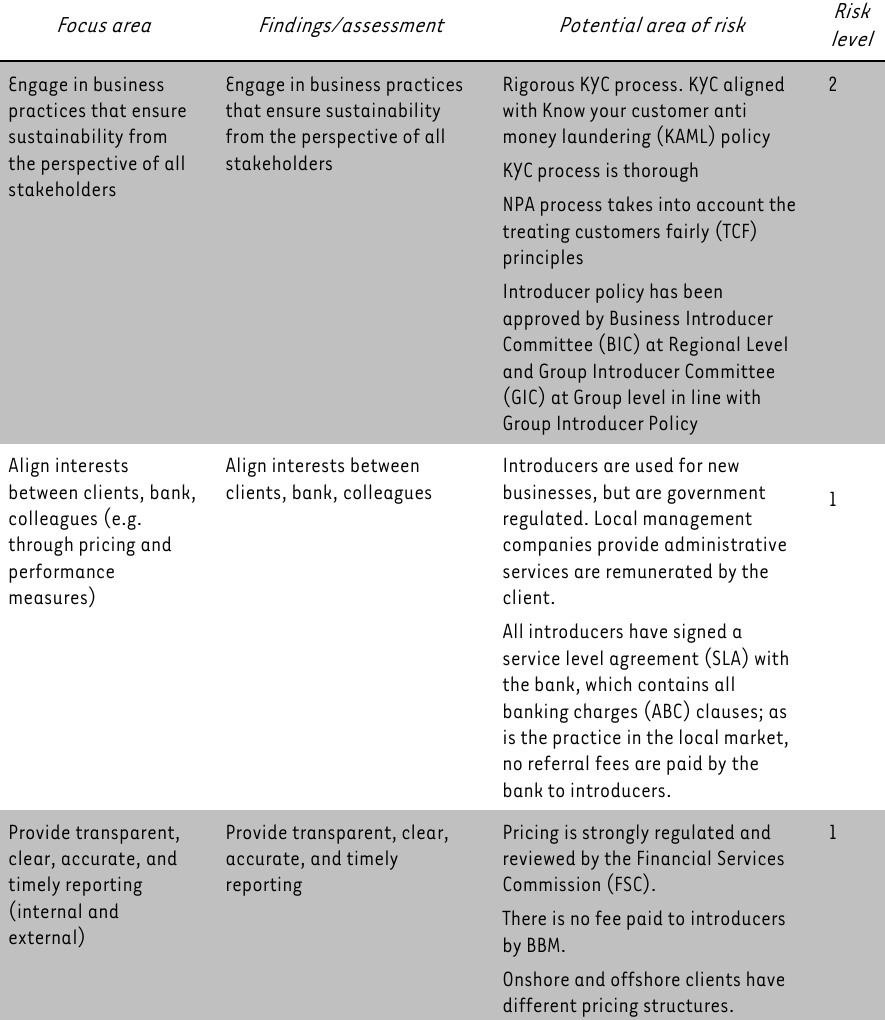
TABLE 8: Data depicted in template ‘how’ Focus